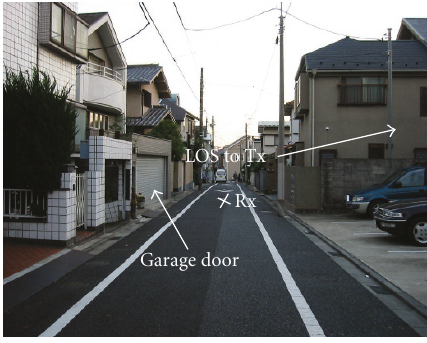
Figure 22: Environment around Rx.